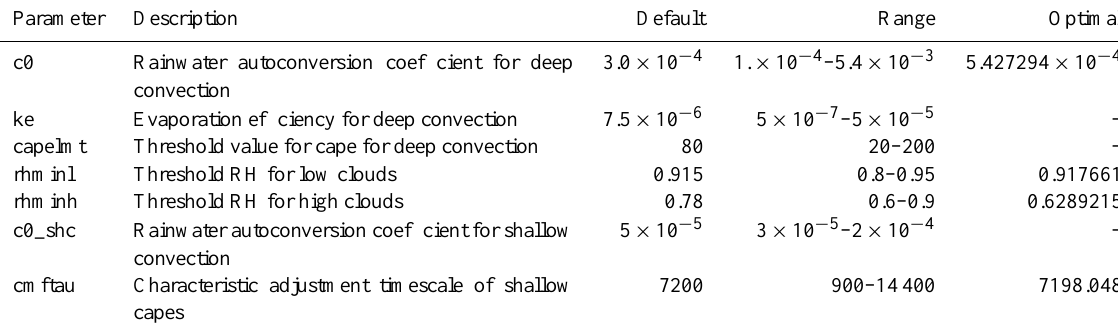
Table 1. A summary of parameters to be tuned in GAMIL2. The default and final tuned optimum values are also shown. The valid range of each parameter is also included. Note that only four sensitive parameters are tuned and have optimum values.